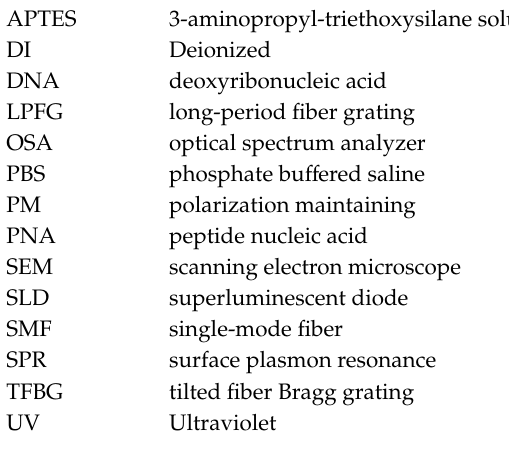
Figure S1: Wavelength and transmission loss analysis for glucose by U-shape diameter at 1.11 mm, Figure S2: Wavelength and transmission loss analysis for glucose by U-shape diameter at 1.5 mm, Figure S3: SEM image of the biosensor surface, Figure S4: Three cycles of spectrum of the Mahlavu assay with U-shaped optical fiber, Figure S5: Analysis of transmission loss of Mahlavu assay in three cycles. Table S1: Comparison between this study and reported works on optical fiber